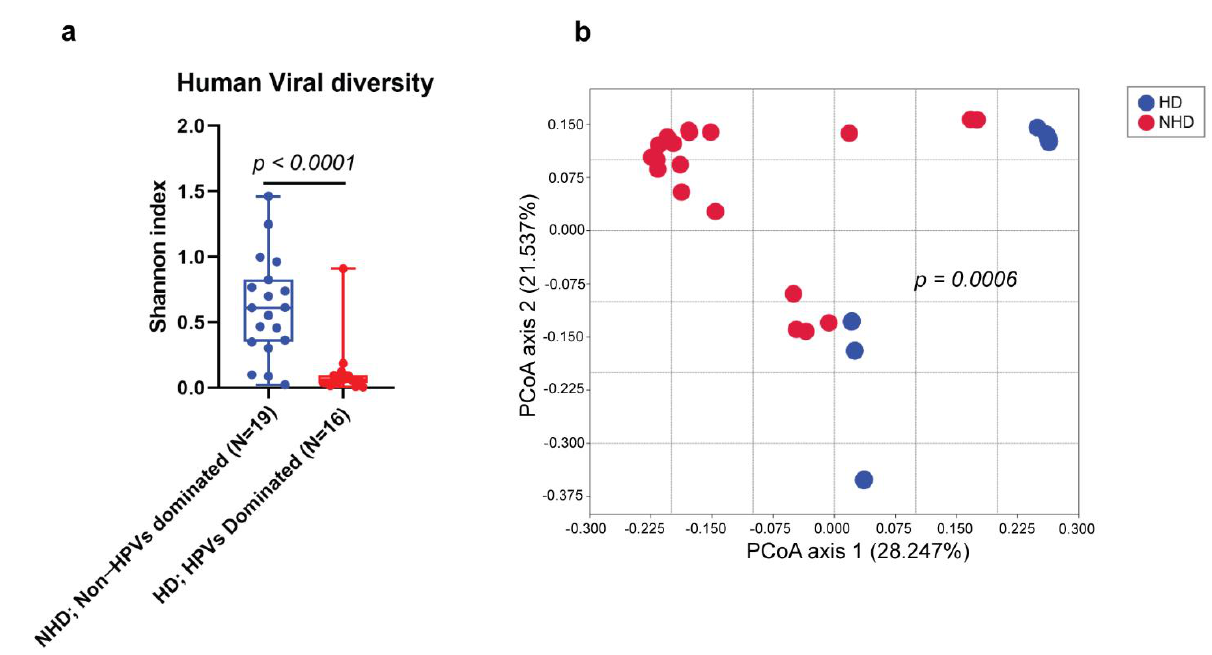
Figure 2. Viral diversity in HD and NHD groups. ( a ) Shannon (Alpha) diversity, ( b ) β -diversity using principal coordinate analysis (PCoA) based on Bray-Curtis dissimilarities. Error bars represent the standard error of mean (SEM).